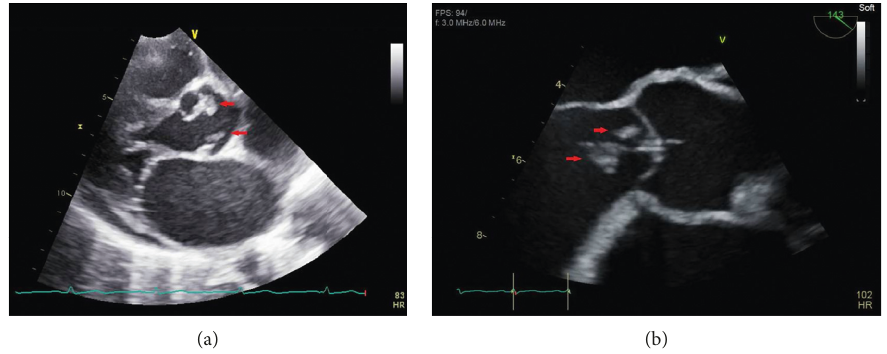
Figure 2: Large aortic valve vegetations on echocardiogram, shown in red